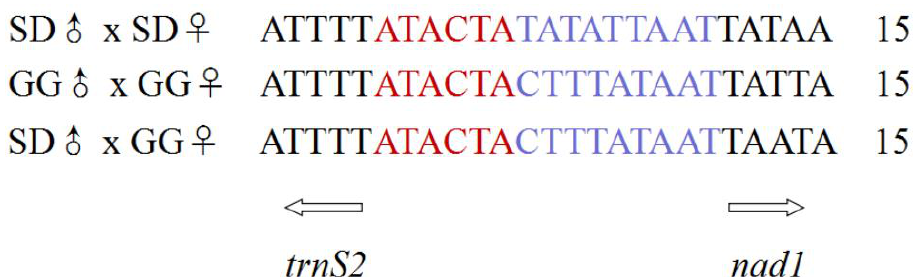
Figure 4. The highly conserved intergenic spacer located between the trnS2 and nad1 .